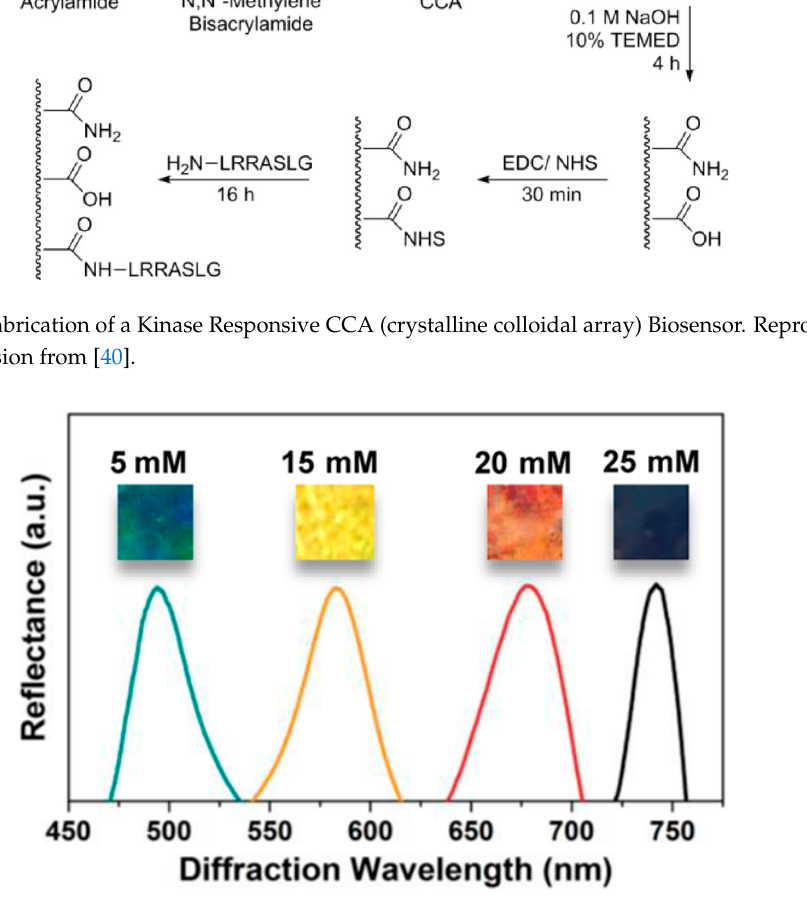
Figure 15. ( A ) Enzymatic reaction between penicillinase and penicillin G; ( B ) Schematic illustration of the PCCH (penicillinase colloidal crystal hydrogel) sensor for the detection of β -lactam antibiotic and β -lactamase inhibitor. Reproduced with permission from [41]. 3.3. Combination of 3DOCs with Other Technologies 3DOCs as carriers and labels combined with surface enhanced Raman scattering (SERS) for the dual encoding of multiplex bioassays. Precision medicine has become one of the new generations of research in life sciences with the feature of harnessing big data. Acquisition techniques of bioinformation draw much attention to obtain both high throughput sequencing and screening based on multiplex bioassays. The combination of encoding elements and detection label in different modes make it possible to enlarge the analyte throughput by dual or complex encoding. In one case, capture antibodies were covalently attached on the surface of silica nanoparticle-based 3DOCs [28].